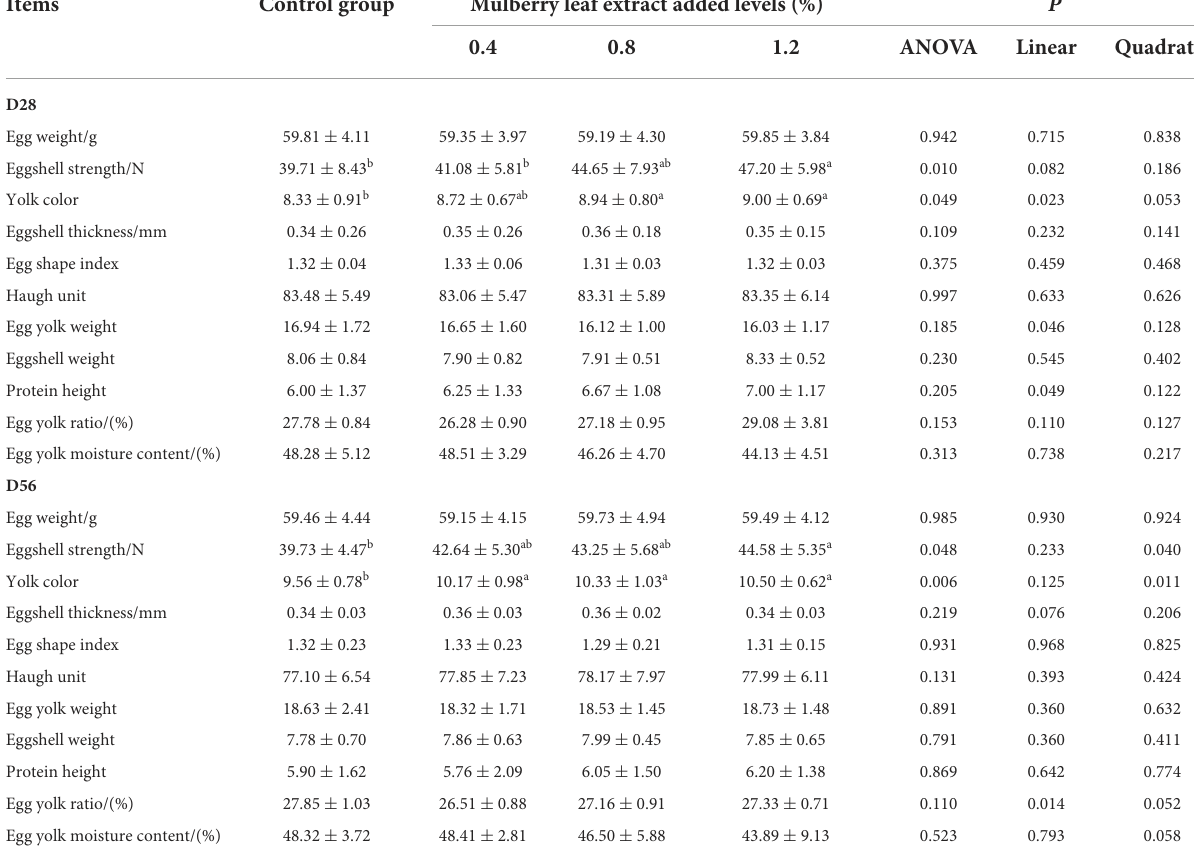
TABLE 4 Effects of mulberry leaf extract on egg quality of laying hens.